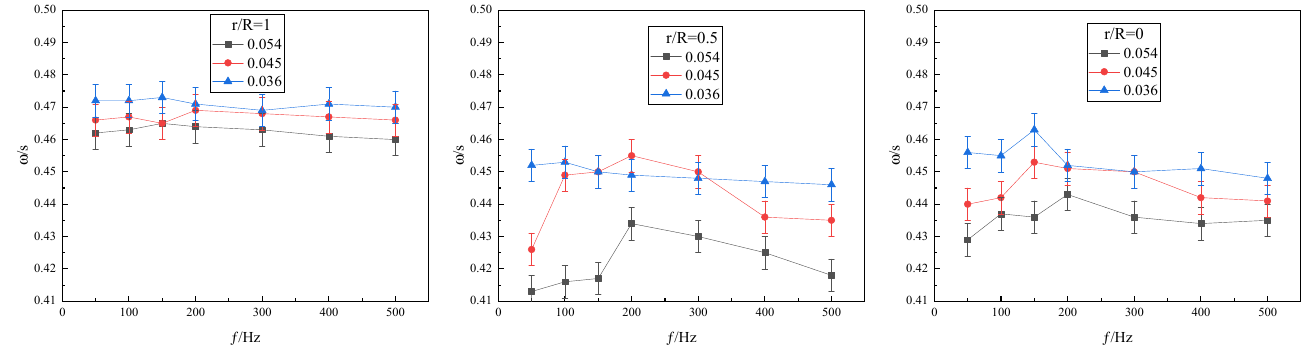
Figure 8. Radial distribution of the particle concentration at different acoustic frequencies.